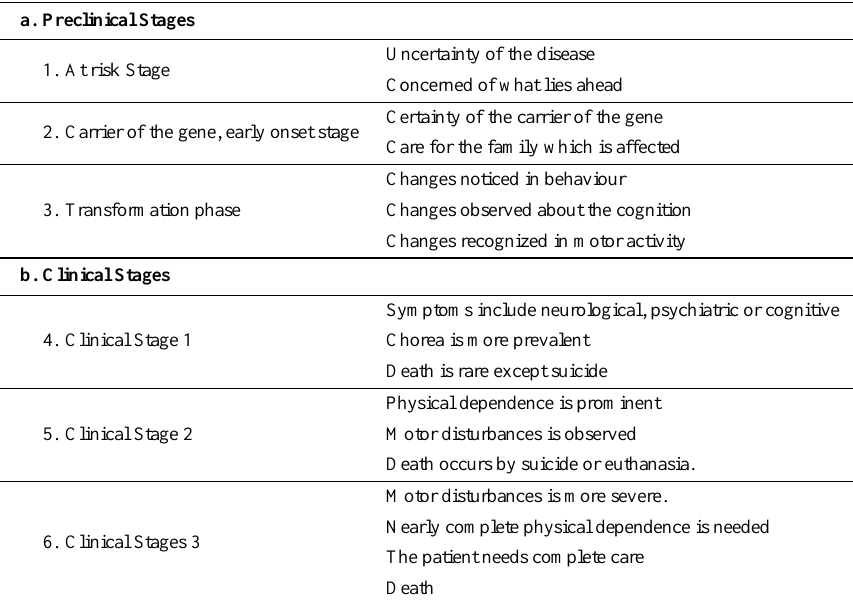
Table 1. The stages in Huntington’s